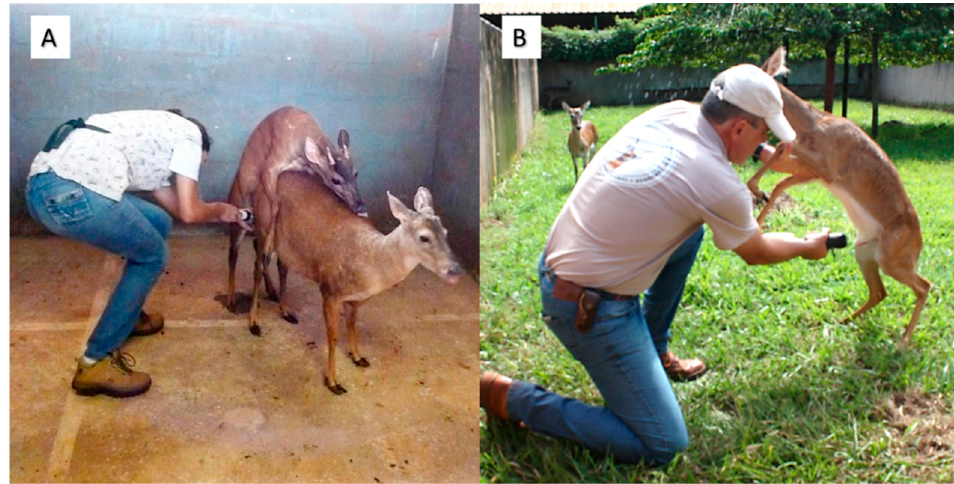
Figure 1. Seminal collection using an artificial vagina. ( A ) Use of female in estrus to perform lateral deviation of the penis. ( B ) Conducting collection in male with